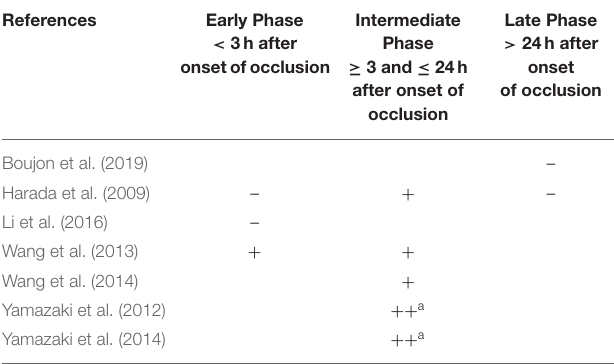
TABLE 3 | Hypothesis decision in the different ischemia